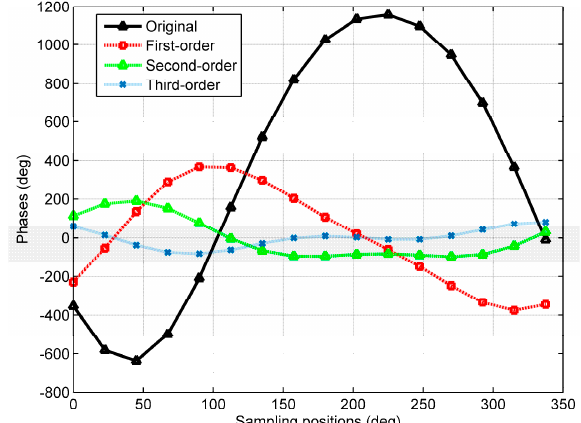
Figure 2. Original and high-order difference phases for N = 16, ρ 0 = 5 λ , θ s = 30 ◦ , ϕ s = 40 ◦ , and r s = 6 λ